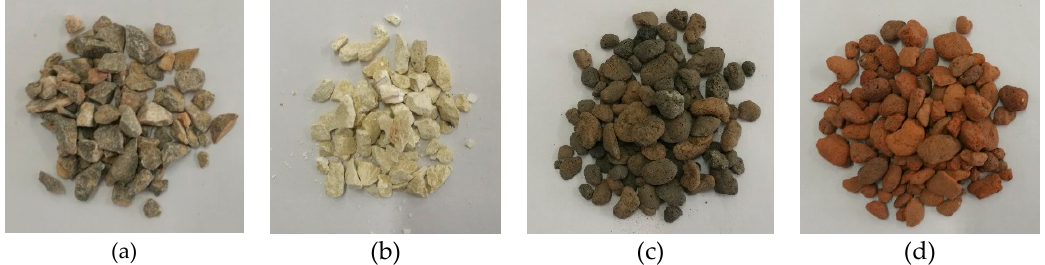
Figure 6. Appearance changes of gravel and ceramsite after exposure to high temperature of 1000 ° C: ( a ) Gravel (20 ° C); ( b ) Gravel (1000 ° C); ( c ) Shale ceramsite (20 ° C); ( d ) Shale ceramsite (1000 ° C).